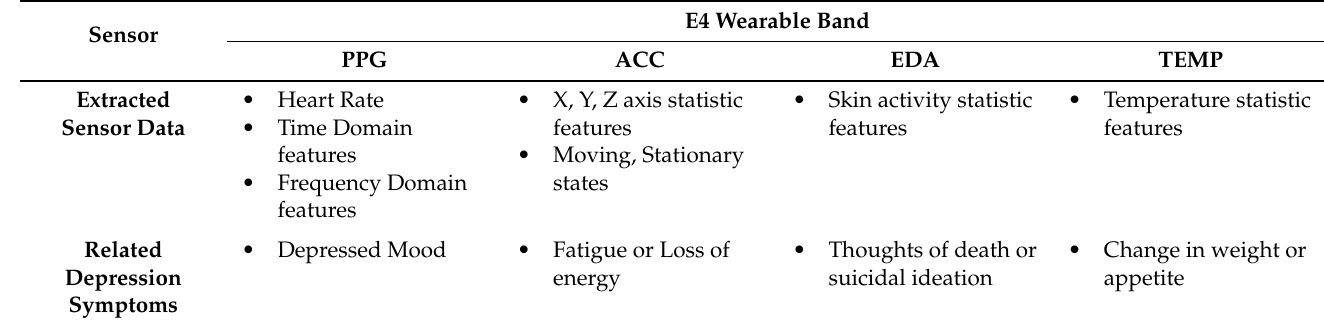
Table 2. Correlation between Sensor Data and Depression